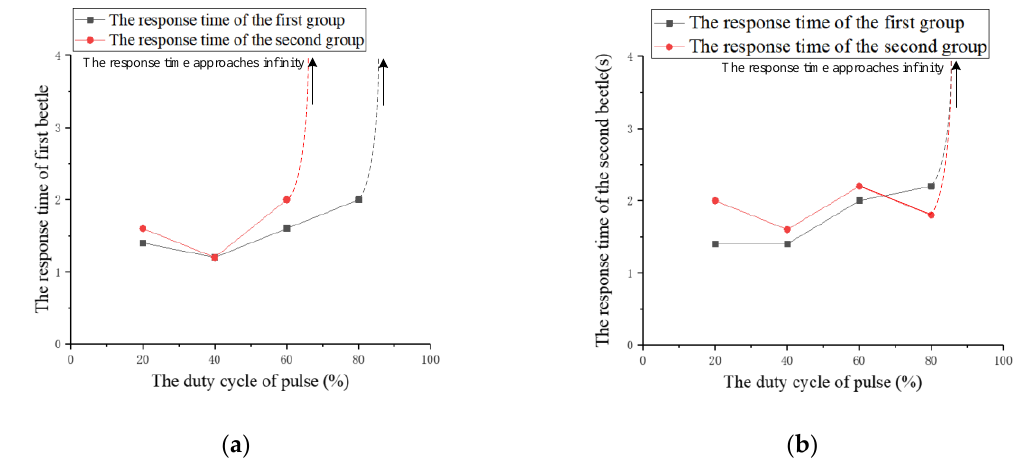
Figure 13. The relationship between the response time of beetles and the duty ratio. ( a ) The first beetle;